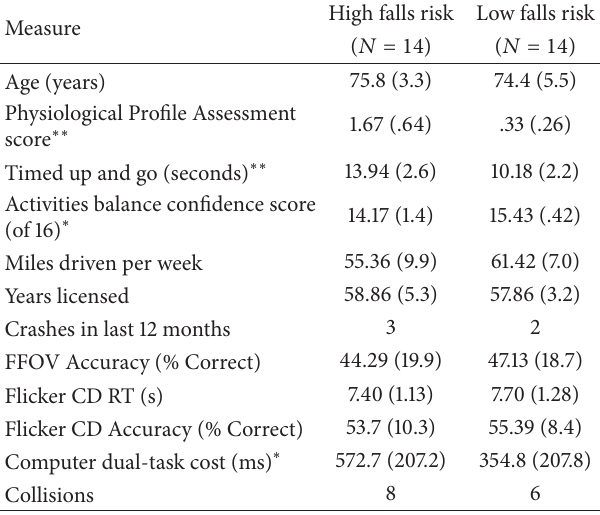
Table 1: Demographic and cognitive measures.